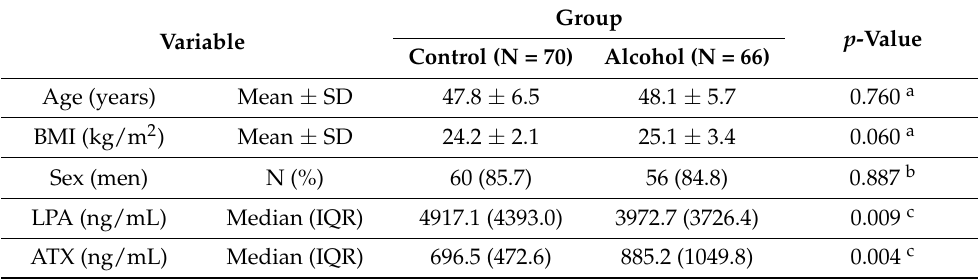
Table 1. Biological characteristics and plasma concentrations of LPA and